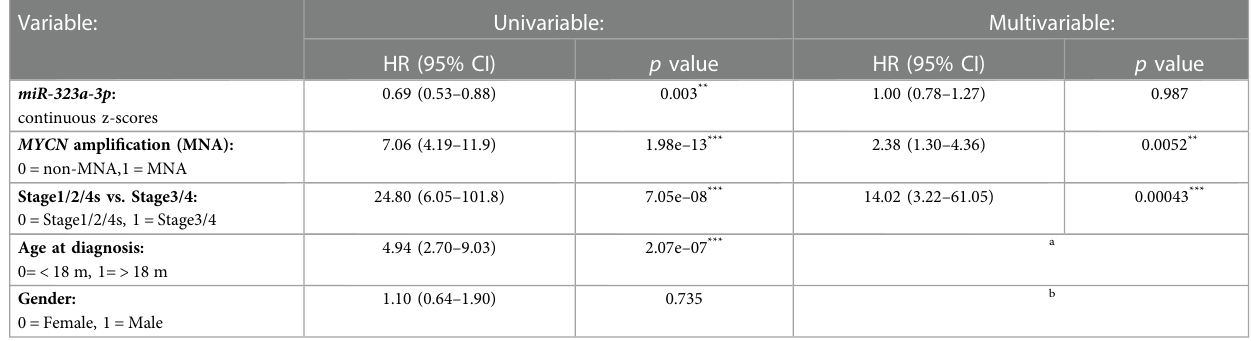
TABLE 2 Cox regression analysis for miR-323a-3p in neuroblastoma tumor dataset. Univariable and strati fi ed multivariable Cox regression analysis of the correlation between miR-323a-3p expression and clinical features for overall survival in the NRC-226